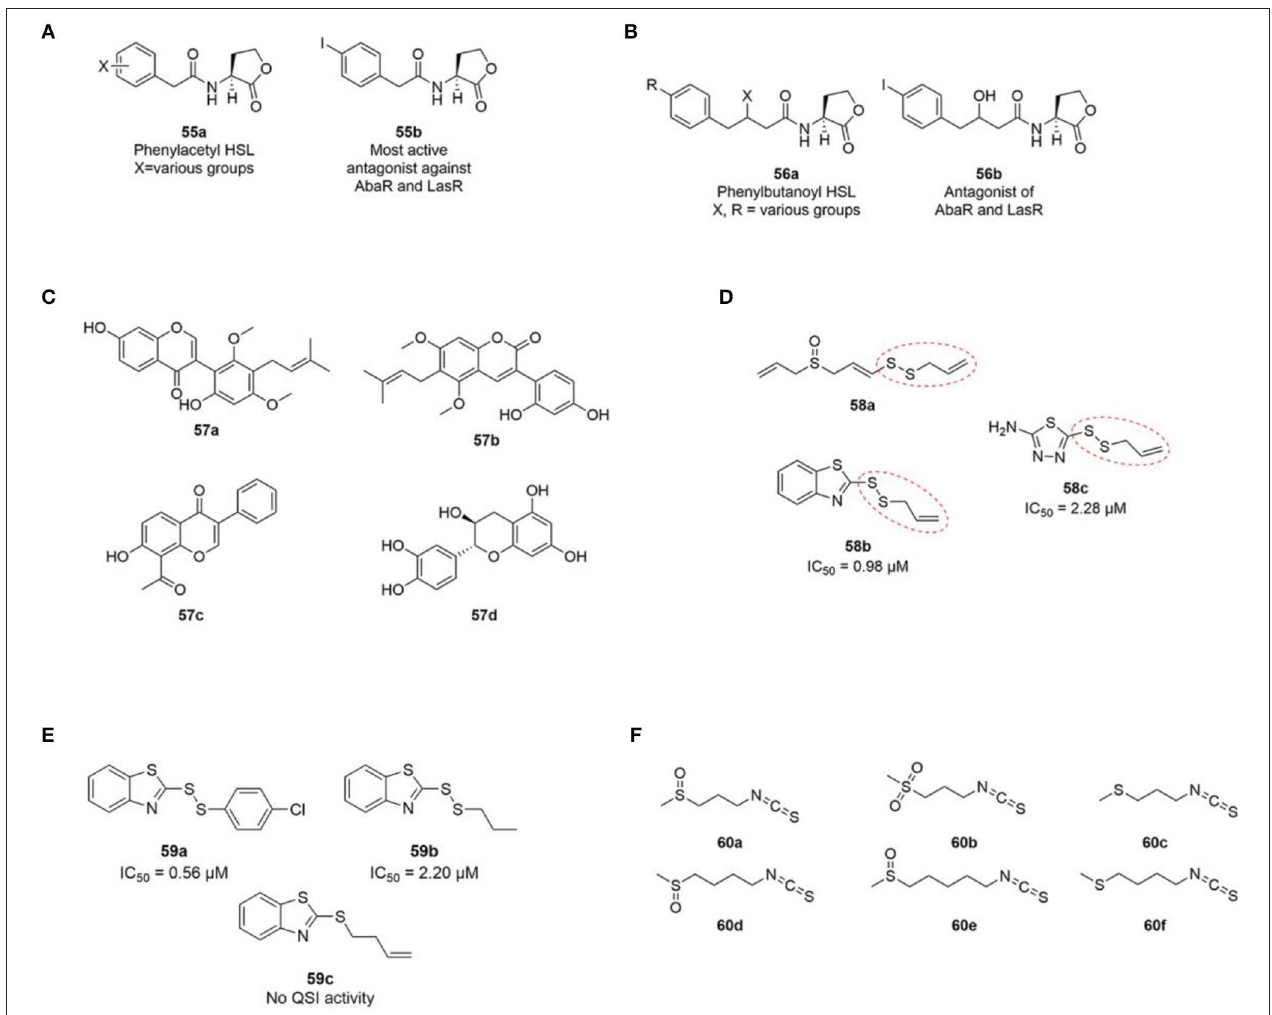
FIGURE 15 | (A) General phenylacetyl HSL (PHL) ( 55a ) and the most active PHL antagonist ( 55b ) against AbaR (Stacy et al., 2012) and LasR (Geske et al., 2008c). (B) General phenylbutanoyl HSL (PBHL) ( 56a ) and one of the most active PBHL antagonist ( 56b ) against AbaR and LasR (Gerdt et al., 2017). (C) Structures of licoricone ( 57a ), glycyrin ( 57b ), glyzarin ( 57c ) and flavan-3-ol catechin ( 57d ). (D) Structure of ajoene ( 58a ) and two additional inhibitory QSI inhibitors ( 58b and 58c ) identified from a random screening by Fong et al. (2017). (E) Ajoene analogs synthesized by Fong et al. (2017). (F) Structures of iberin ( 60a ), cheirolin ( 60b ), iberverin ( 60c ), sulforaphane ( 60d ), alyssin ( 60e ) (Jakobsen et al., 2012a), and erucin ( 60f ) (Ganin et al., 2013) with QS inhibitory activity against P. aeruginosa